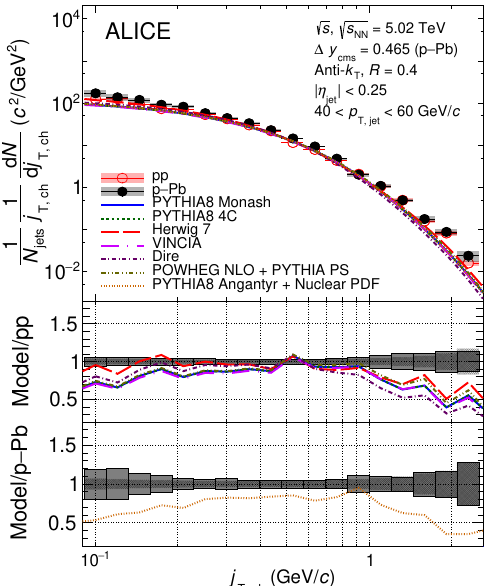
√ √ s, s NN = 5 . 02 TeV for 40 < p T , jet <